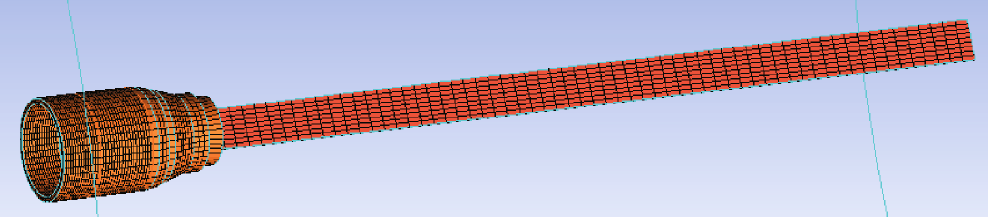
Figure 6: Three-dimensional grid of the